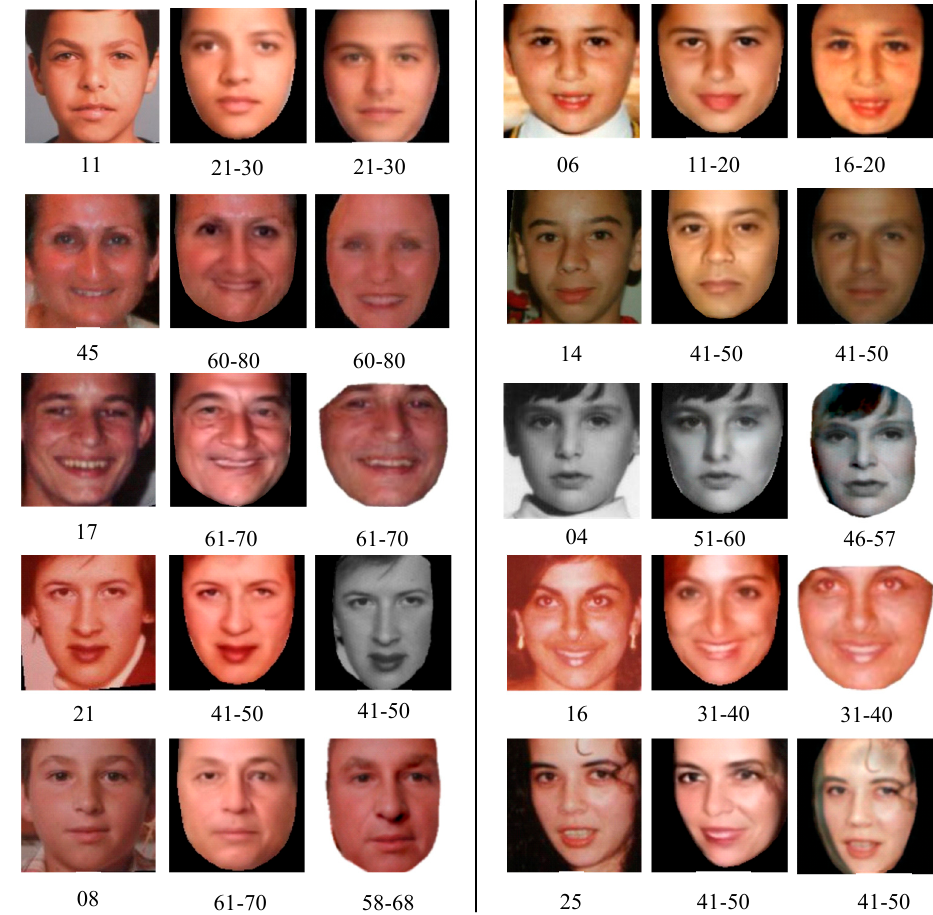
Figure 13. Compared with prior works.